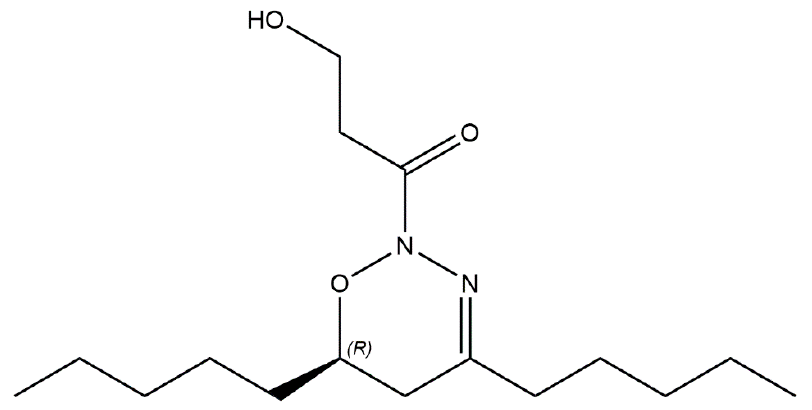
Figure 6. Chemical structure of the identified bioactive metabolite nocuolin